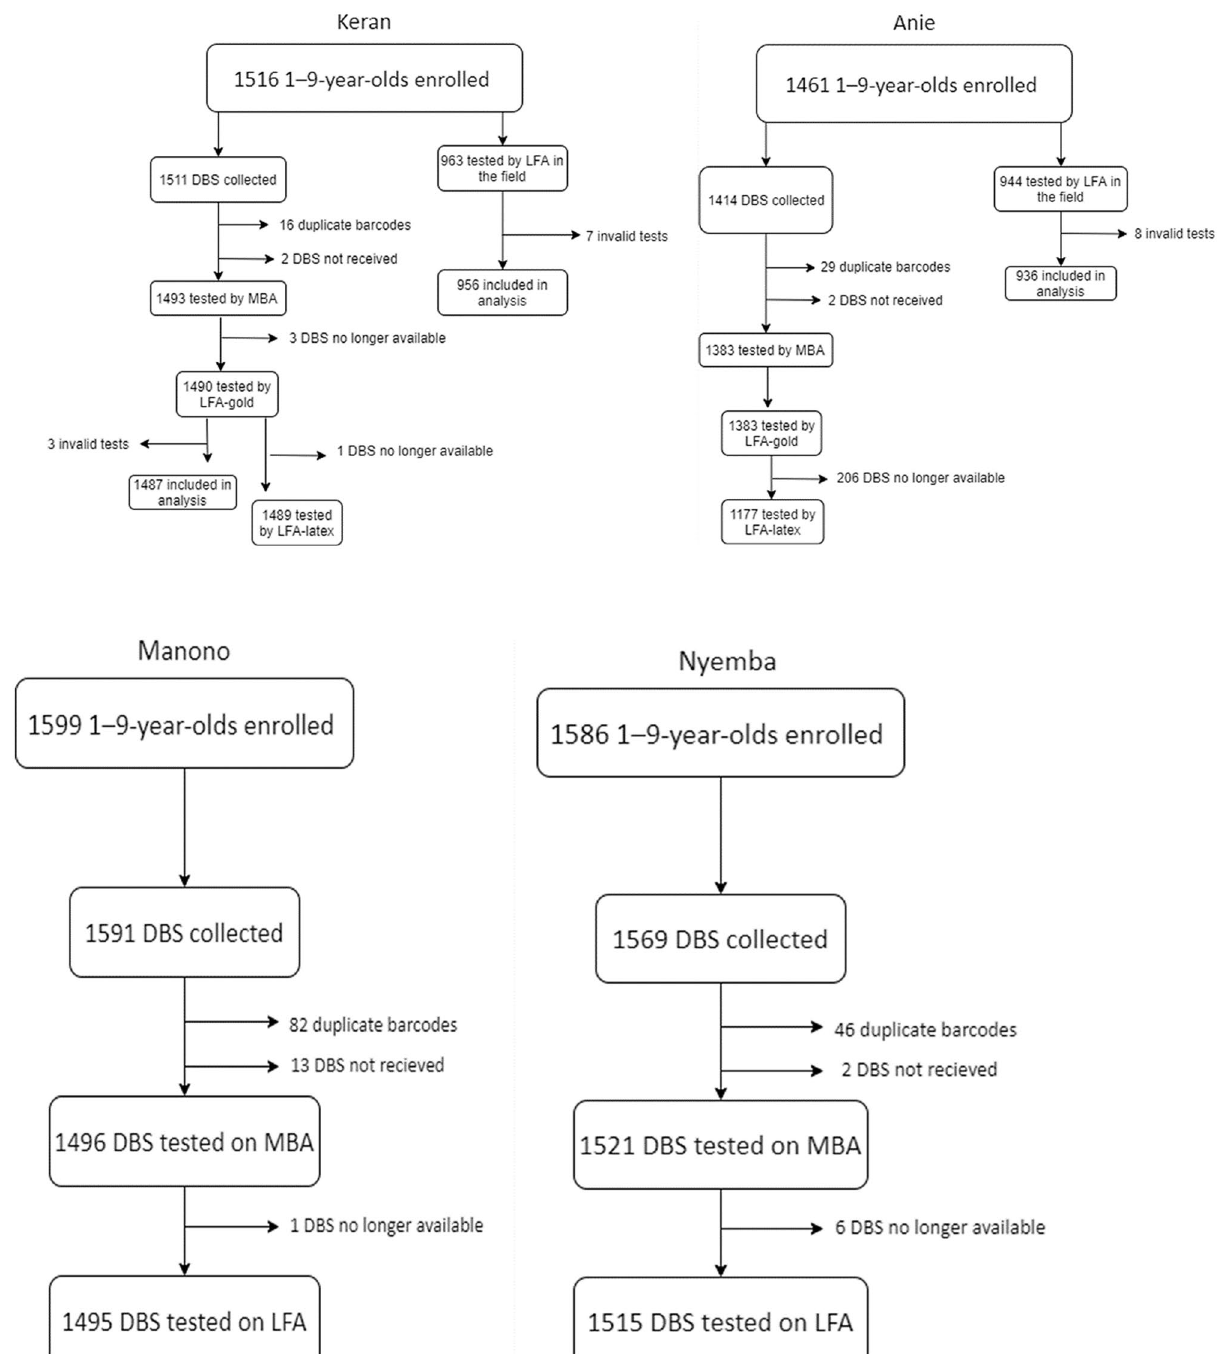
Figure 1. Flow chart of sample collection in each evaluation unit. Figure was created using draw.io version 14.3.1 (https:// app. diagr ams.